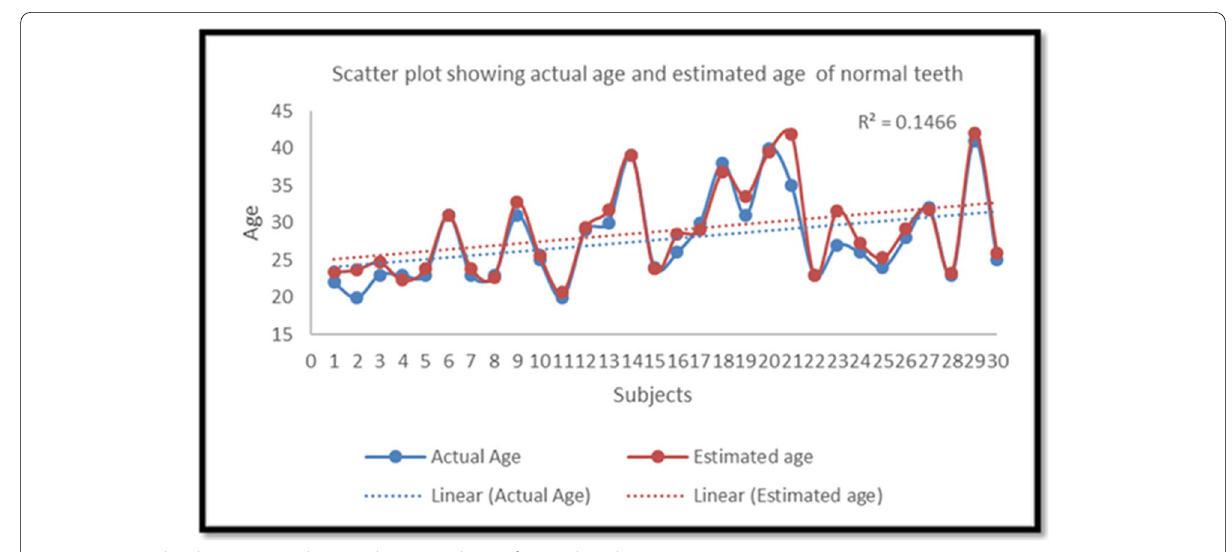
Fig. 6 Scatter plot showing actual age and estimated age of normal teeth